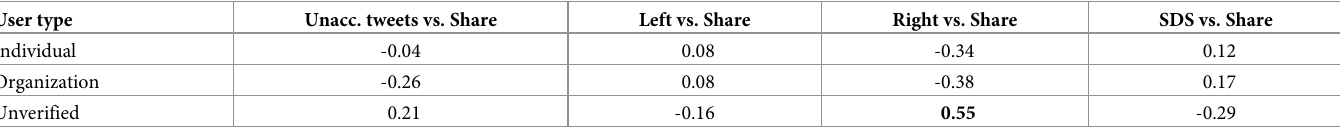
Table 10. Comparison of the three major user types by Cohen’s h . The headings denote the first property (the proportion p 1 ) vs. the second property (the proportion p 2 ). The values of h in the body have the following interpretation: positive sign of h shows that p 1 > p 2 , and the value of | h | indicates the effect size. In bold is the value of h > 0.50, indicating at least medium effect size. User type Unacc. tweets vs. Share Left vs. Share Right vs. Share SDS vs. Share